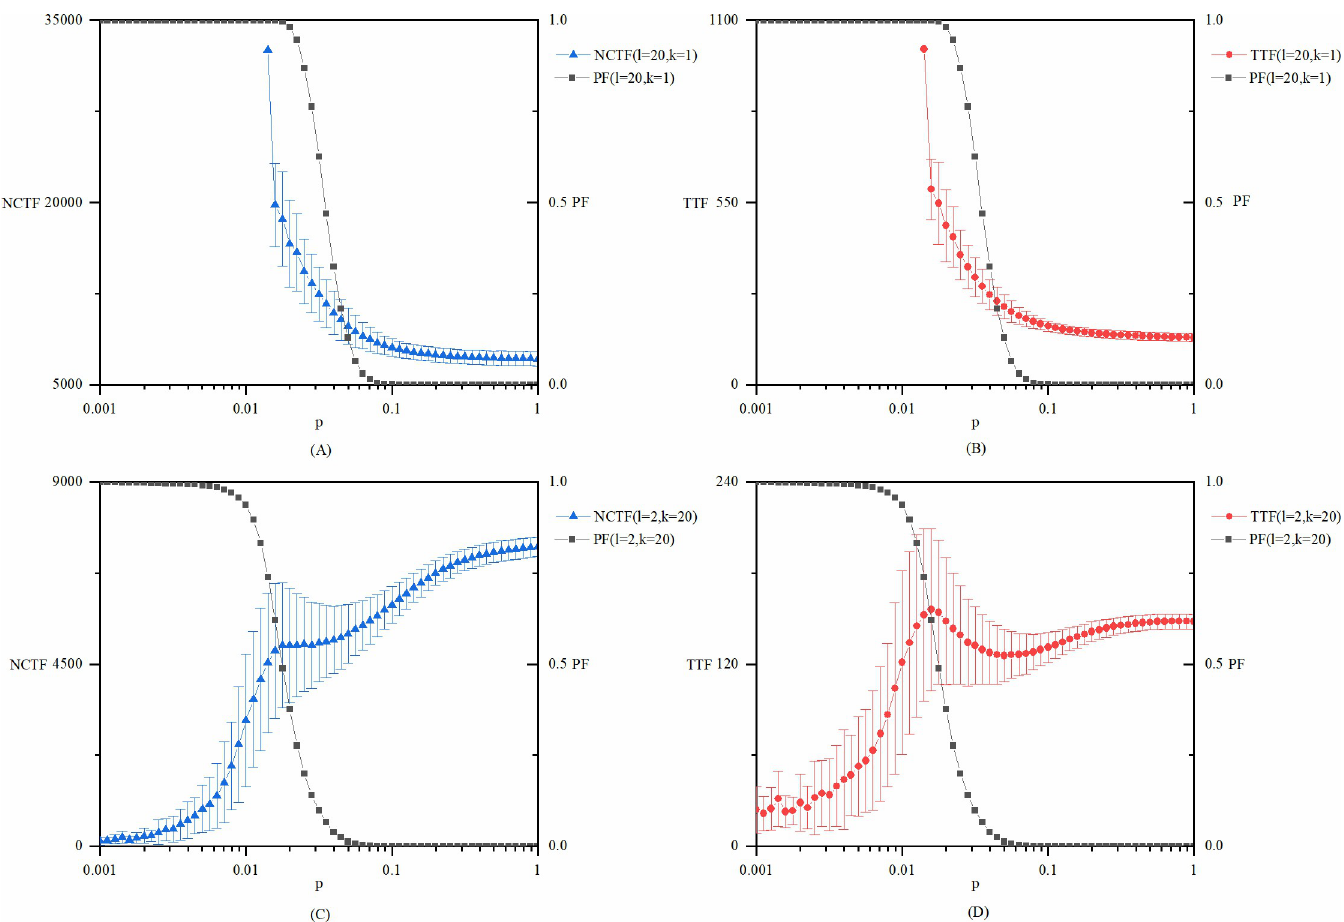
Fig 9. The model results with dv varies with the knowledge level of the receivers. (A) NCTF and PF of explorative innovation. (B) TTF and PF of explorative innovation. (C) NCTF and PF of exploitative innovation. (D) TTF and PF of exploitative innovation. Specifically, the value of dv = 0.01( v i − v j )( v j +1) is used in this experiment, as v denotes the receiver of knowledge in this j